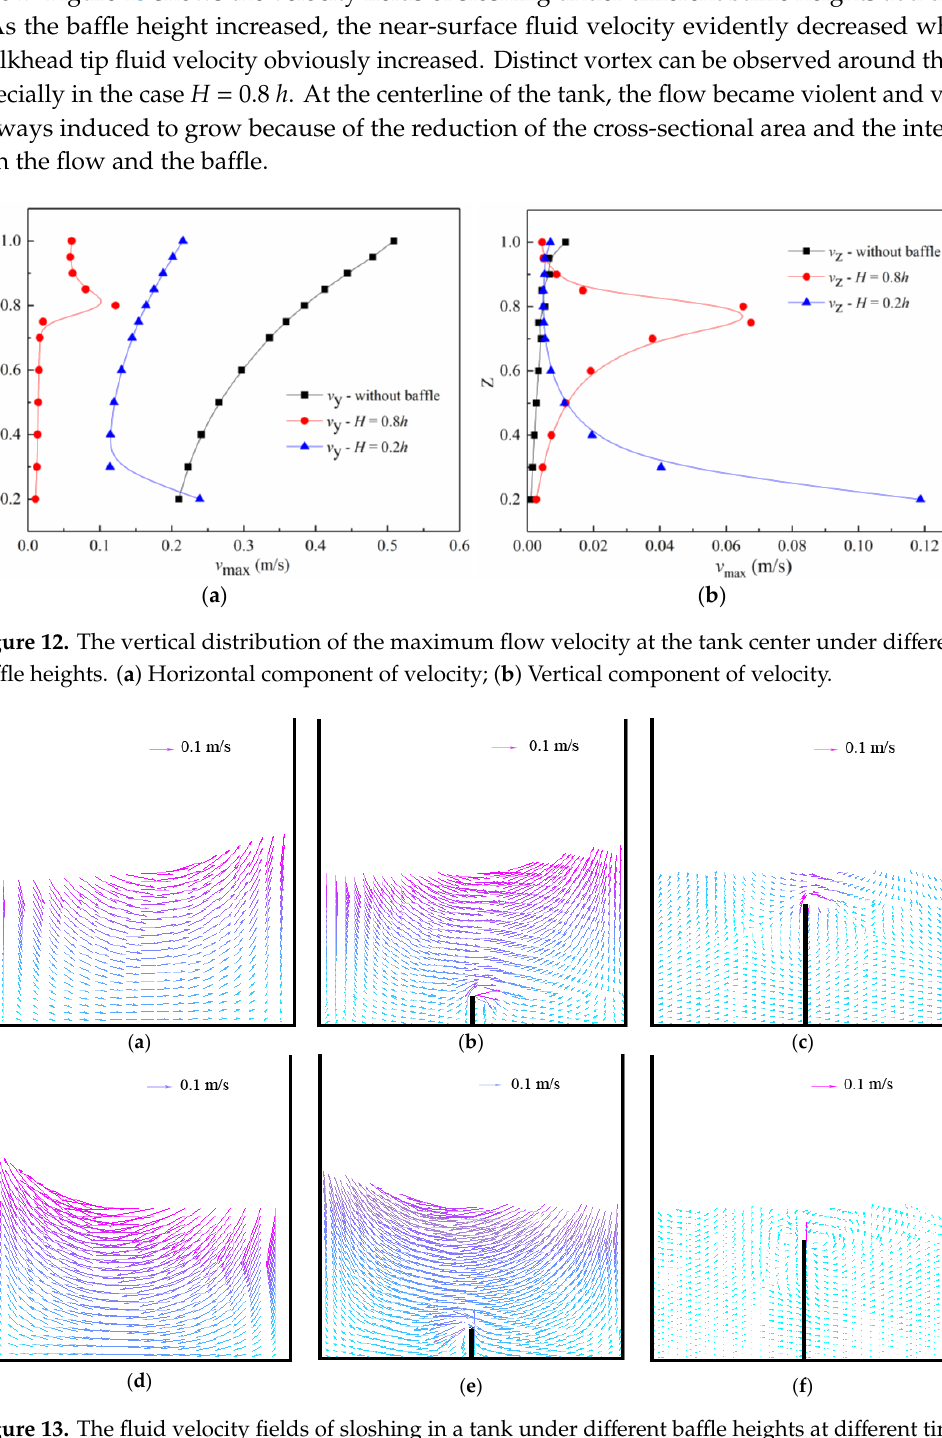
Figure 11. Time series of free surface elevation at y = 0 of sloshing in the tank under different baffle heights.